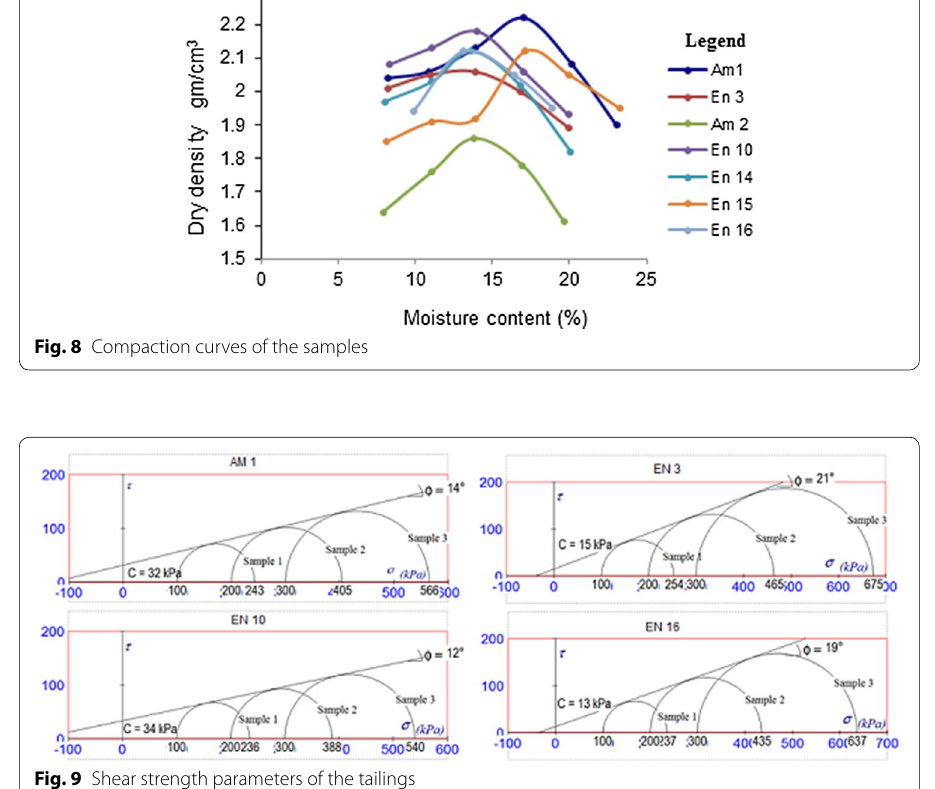
Fig. 9 Shear strength parameters of the